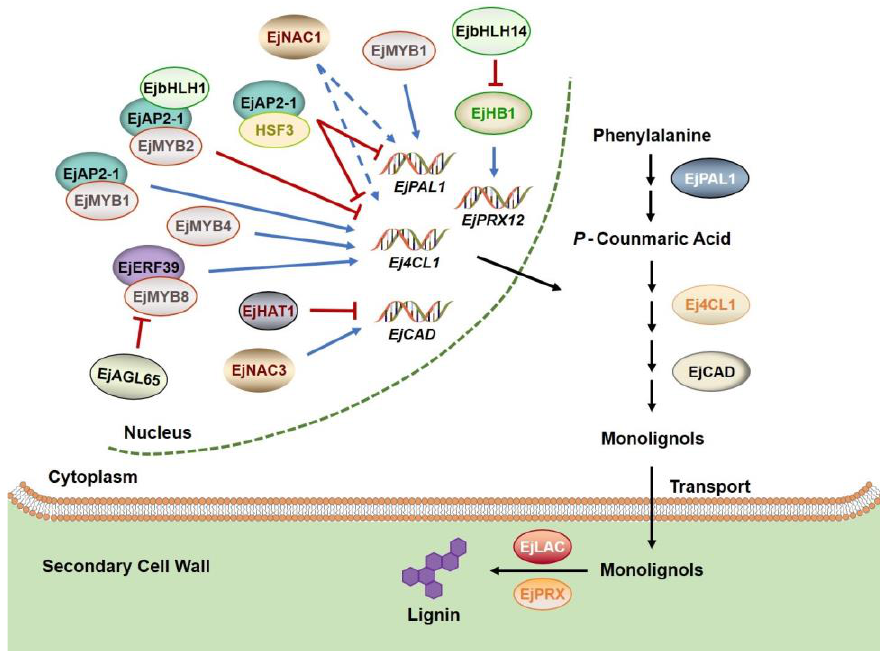
Figure 2. Current understanding of the transcriptional network of lignin biosynthesis in loquat. The blue arrow lines indicate activation, and the red blunted lines indicate repression. The dashed arrows represent indirect regulation. The overlapping ellipses represent protein – protein interactions.